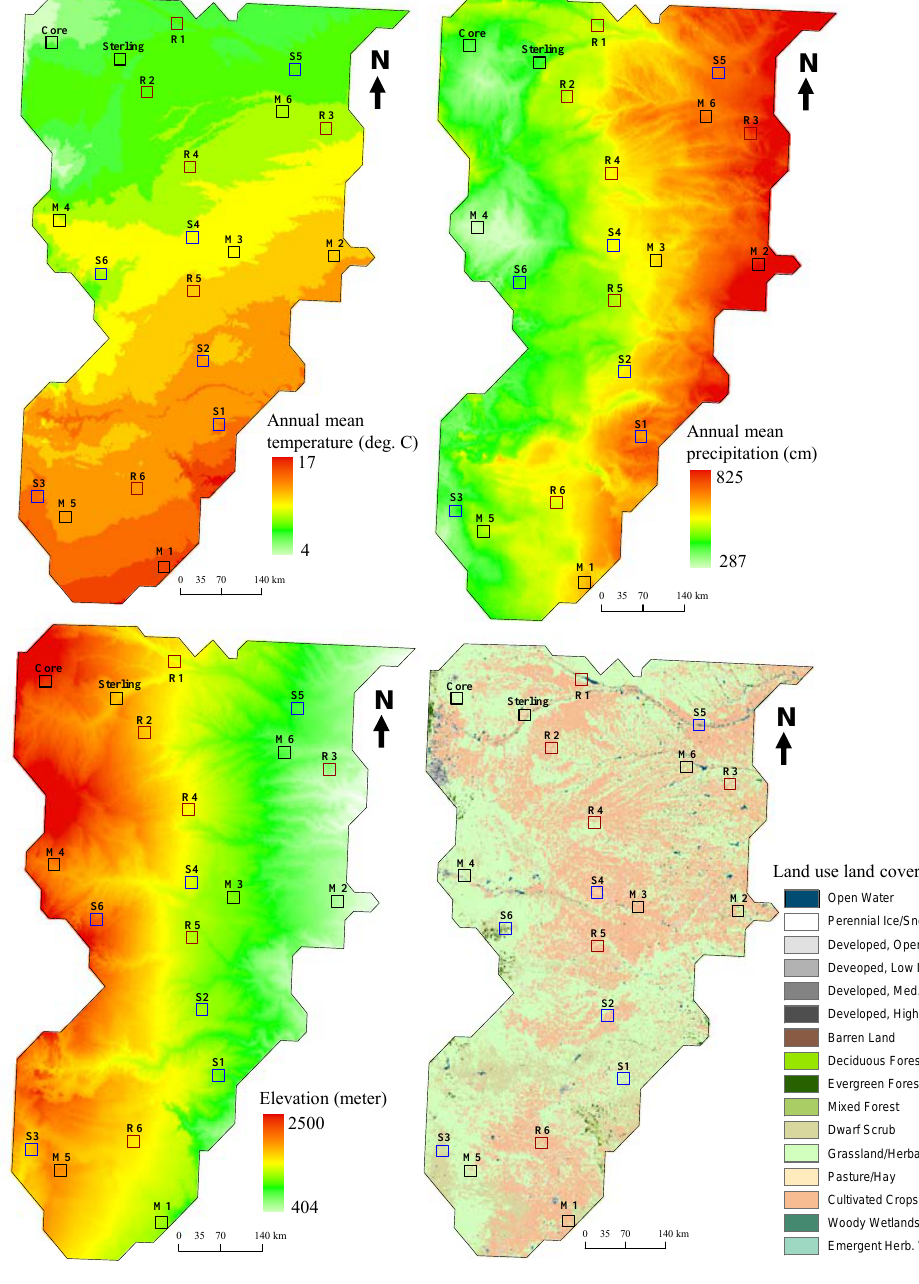
Figure 1. Major environmental gradients and vegetation in the Central Plains domain. M1 to M6 are the sites selected using Maxent dissimilarity criteria, S1 to S6 using